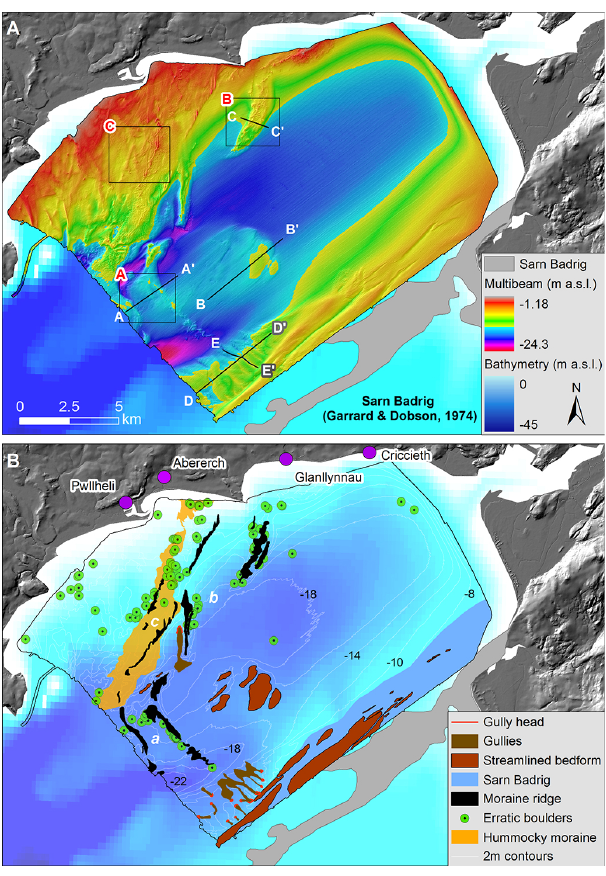
Figure 2. (A) Hillshaded high-resolution bathymetry of Tremadog Bay with locations of the transects in Fig. 3 identified. Inset boxes relate to close views of the data in Fig. 4. (B) Glacial landforms and features in Tremadog Bay are mapped from multibeam echo- sounder data. Interpreted moraines have been grouped according to suggested mechanisms of deposition. The grey outline of Sarn Badrig is defined from original survey results by Garrard and Dob- son (1974). Contains Maritime and Coastguard Agency bathymetry data © Crown